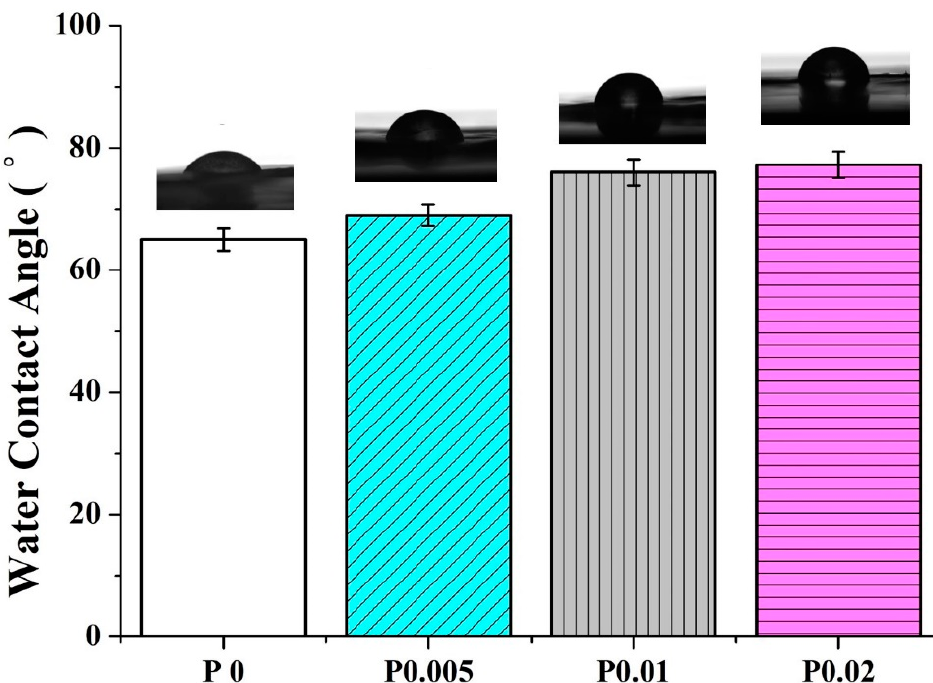
Figure 6. Hydrophilicity of nanofiber membranes as related to the P. emblica content.